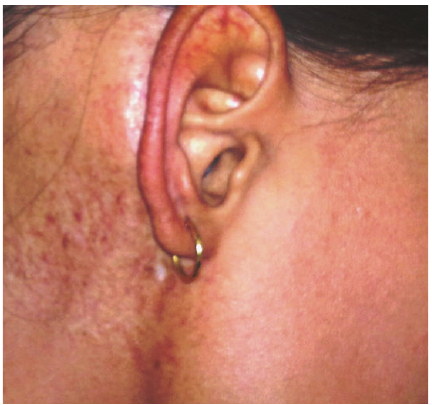
Figure2:Clinicalphotographofthepatientshowingpostradiother- apy